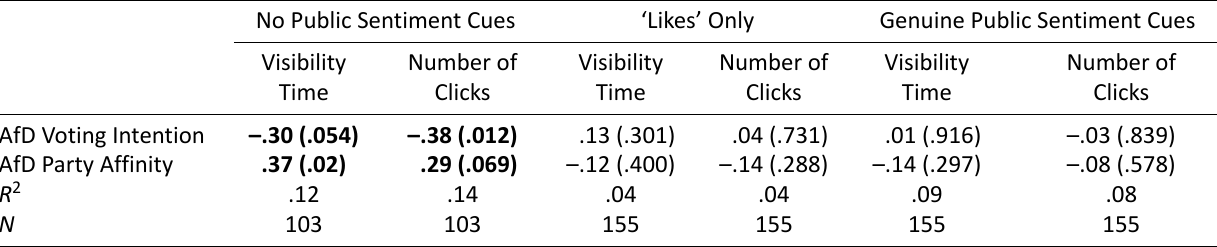
Table 2. Impact of voting intention and political affinity on selective exposure to AfD-critical news posts by public sentiment cue type, beta weights ( p -values in